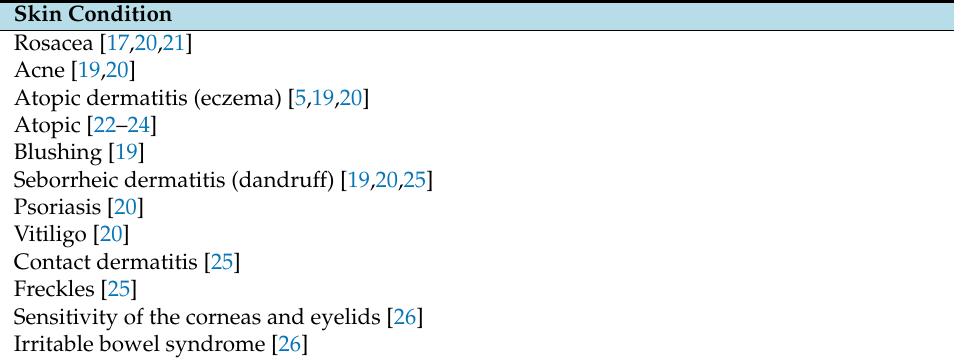
Table 2. Some Skin Co-morbidities Associated with